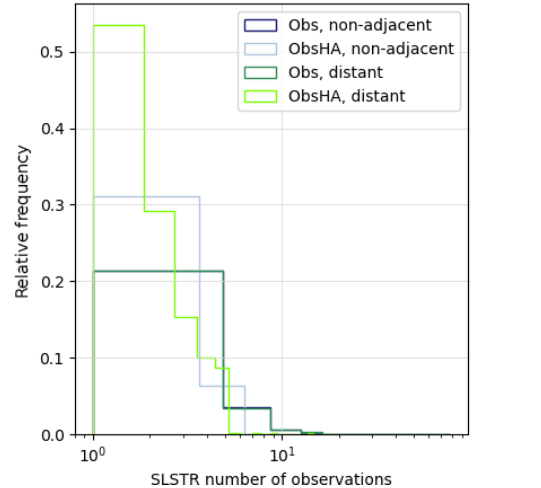
Figure 20. Number of SLSTR-based observations and high- accuracy observations distributions at VNF non-adjacent (the VNF flaring location is ≥ 2 grid cells away from the closest SLSTR- based flaring location) and distant ( > 4 grid cells away) locations. The diminutive number of observations at distant locations supports the argument that our methodology has a tendency to undersam- ple low activity flares when compared to VNF. Our analysis shows that the undersampling is due to less observation opportunities by SLSTR, which can be traced back to a slightly earlier overpass time and a much smaller